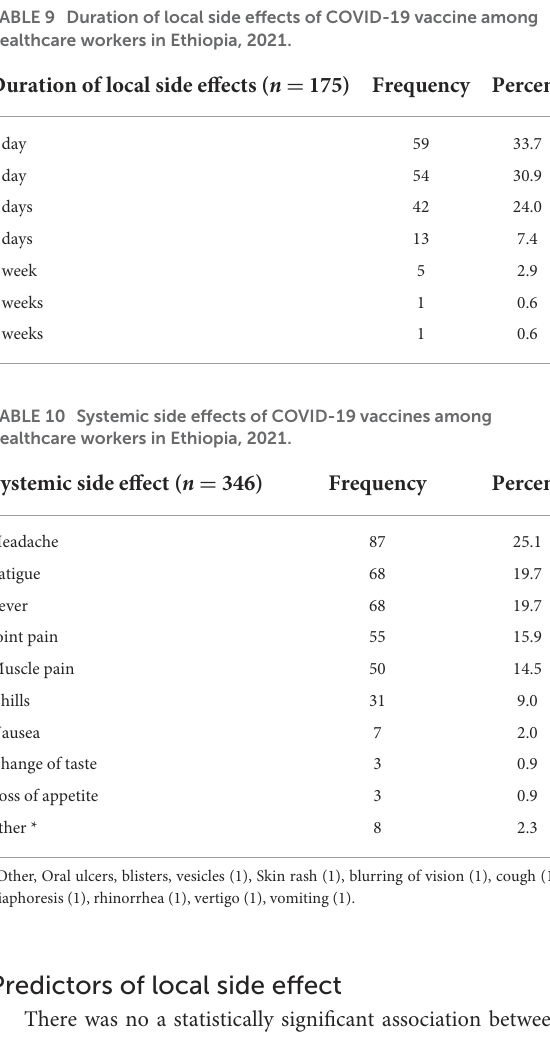
TABLE 9 Duration of local side effects of COVID-19 vaccine among healthcare workers in Ethiopia, 2021.